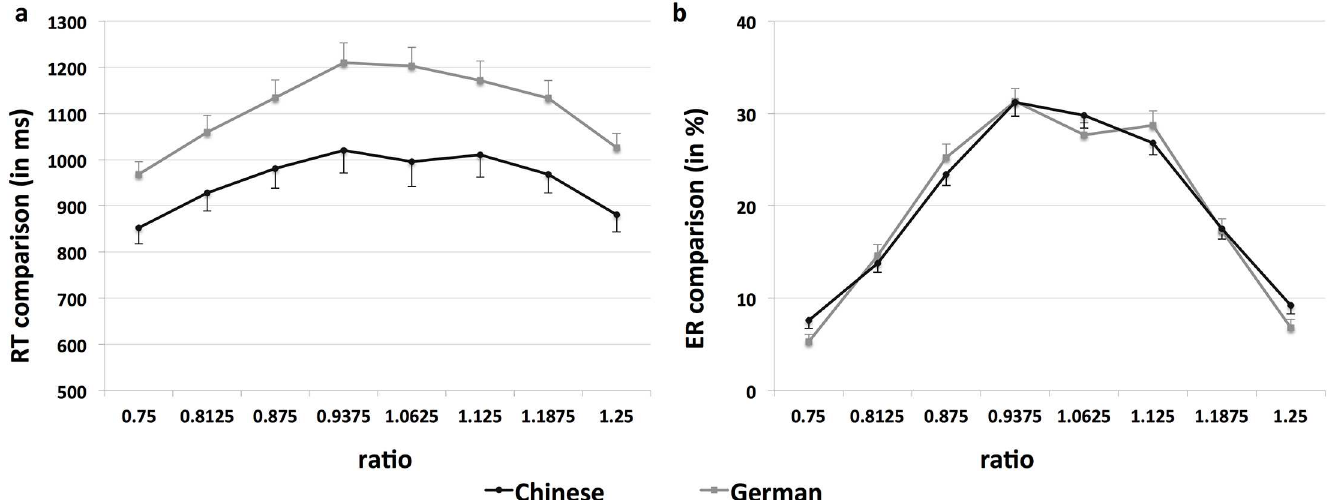
Fig 1. Performance in the non-symbolic numerical magnitude comparison task. Reactiontimes (in ms) and errors (in %) separatelyfor Chinese and German participantsas a function of the different ratios.